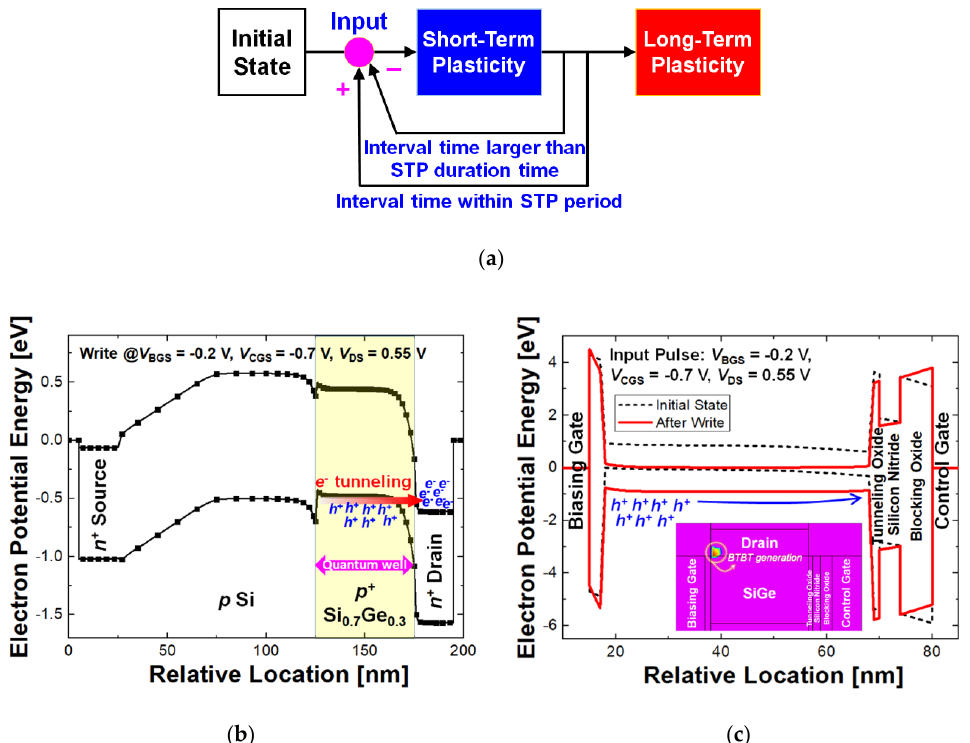
Figure 2. Operation principles of the synaptic device. ( a ) Hebbian’s learning rule. ( b ) Energy-band diagram in the channel direction under the potentiation condition. ( c ) Energy-band diagram at the initial state and after potentiation state. The inset shows the band-to-band tunneling rate over a potentiation event.